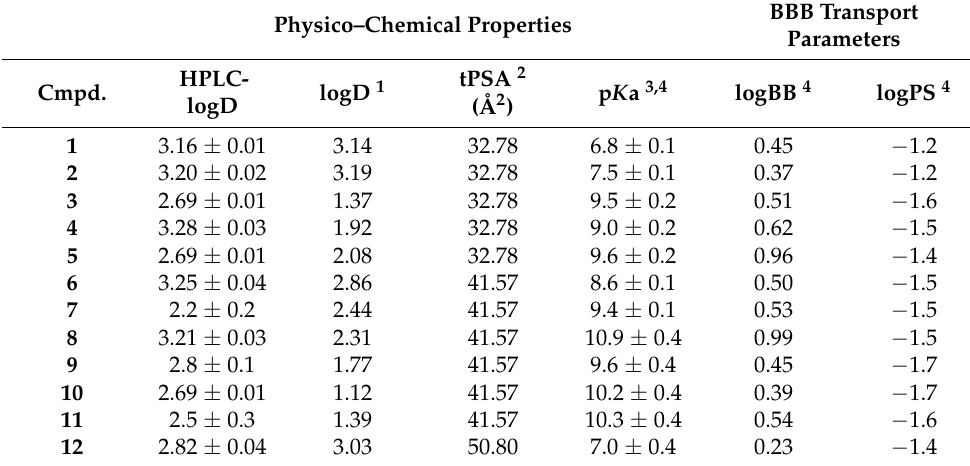
Table 2. Physico–chemical properties and BBB transport parameters of carbamates 1 – 12